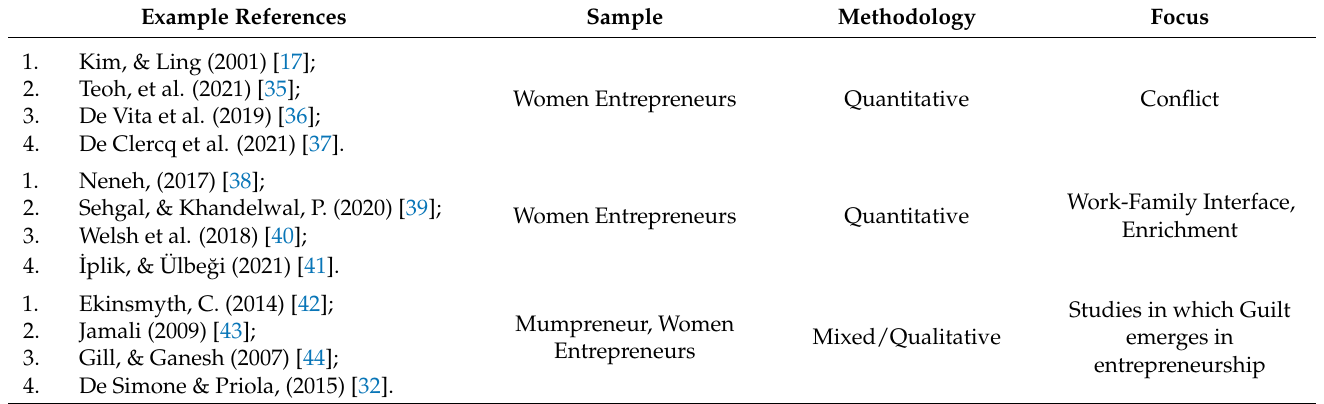
Table 1. Previous